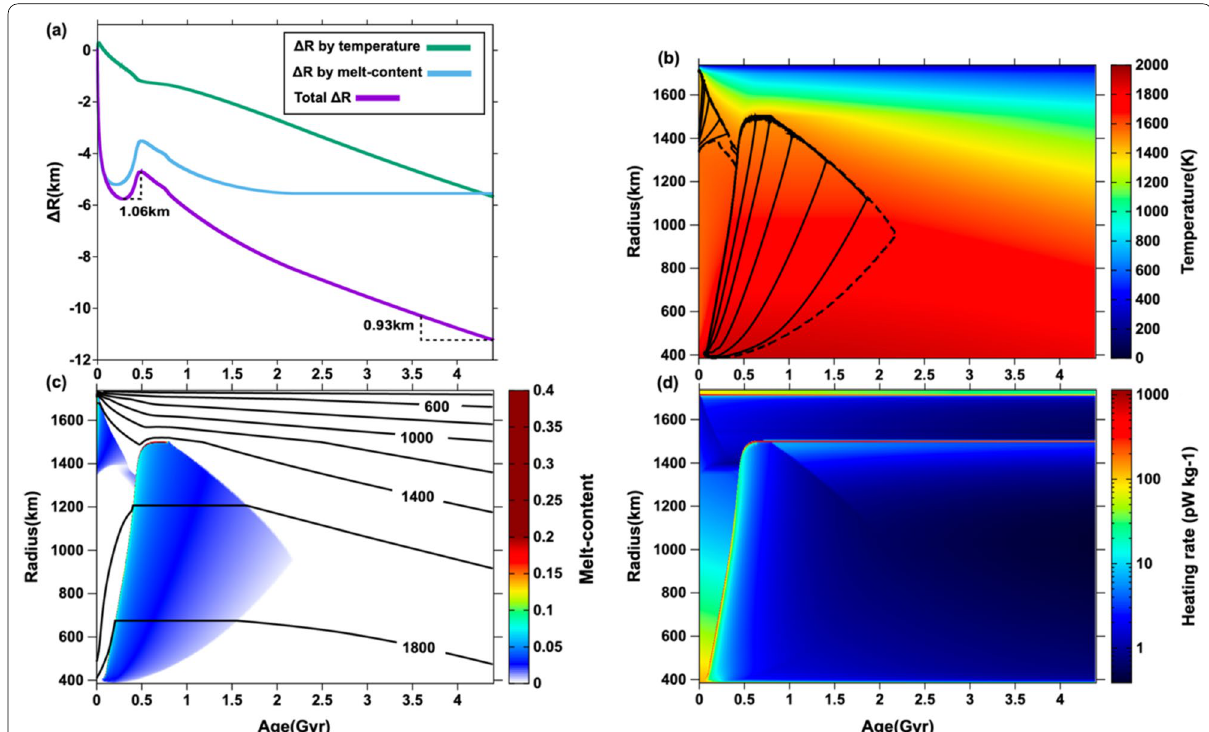
Fig. 5 Model 3. a – c The same as Fig. 4a–c but for Model 3 where HPE-transport by migrating magma is added to Model 2 shown in Fig. 4; transport of the end-members A and B by migrating magma is not considered. d The evolution of HPE-distribution for Model